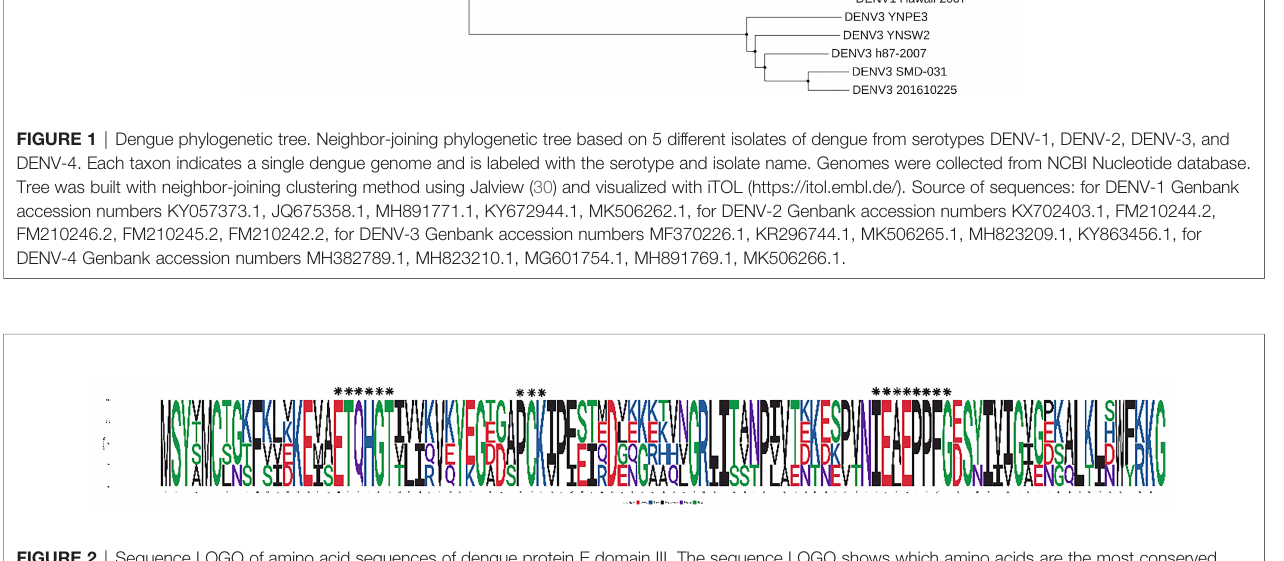
FIGURE 2 | Sequence LOGO of amino acid sequences of dengue protein E domain III. The sequence LOGO shows which amino acids are the most conserved residues among the sequences of domain III of protein E among isolates belonging to different dengue serotypes. Sequences used for this sequence LOGO were obtained from Protein Data Bank (PDB), codes 3IRC for DENV-1, 1TG8 for DENV-2, 4ALA for DENV-4 and 2H0P for DENV-4. Letter height is proportional to amino acid frequencies. The areas of amino acid conservation are marked by black asterisks above the sequence